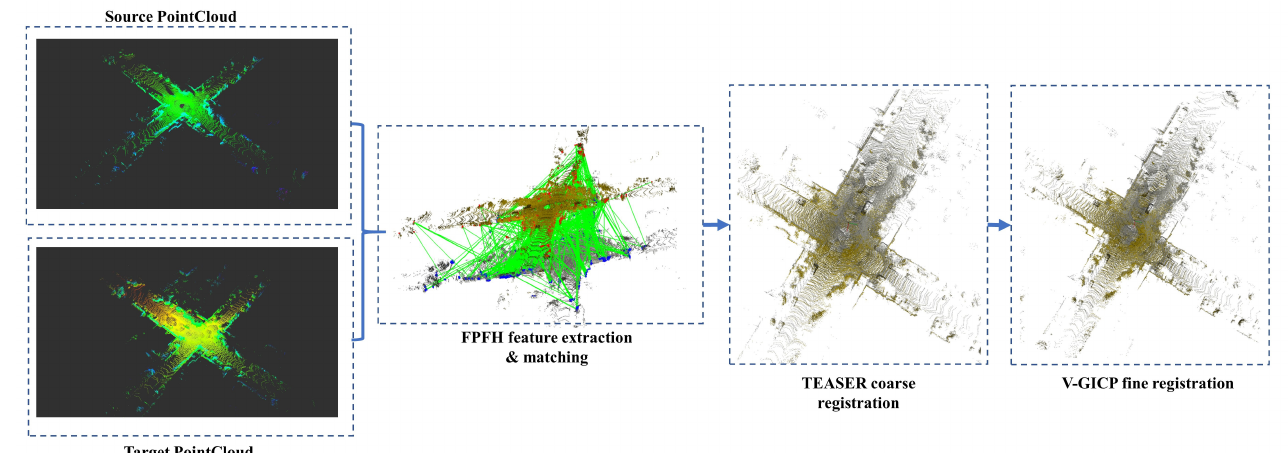
Figure 11. The flow chart of geometry consistency check. The source point cloud and target point cloud were stiched in the cooridinate of query keyframe and candidate keyframe using its neighbor keyframes respectively. The yellow point cloud represent the soure point cloud and gray represent target point cloud start from FPFH feature extraction and matching process. In thre feature extraction and matching process, the red points and blue points represent FPFH feature points respectively, and the green line shows the matching relationship between those points. In order to display clearly, we only show some of the feature points and their matching